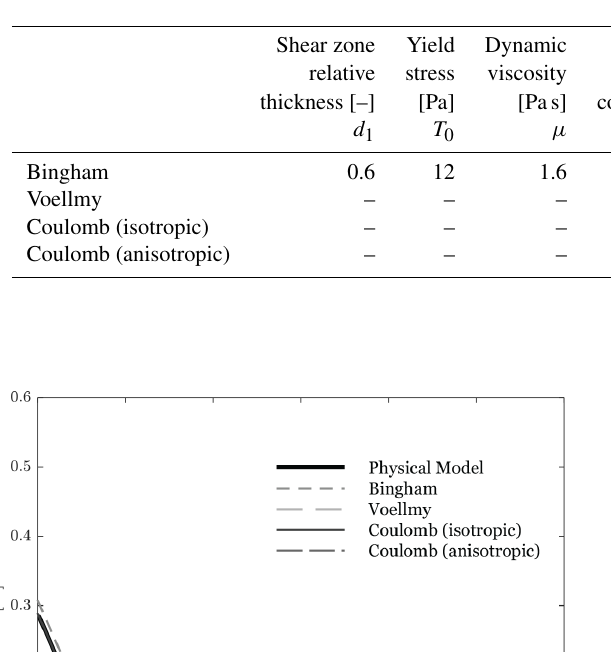
Figure 5. Landslide properties at impact (numerical equivalent location of Cam 1) with a still-water depth h of 0.25m. (a) Time series of slide thickness for different rheological laws (numerical model) compared with the mean thickness in the physical model. (b) Time series of depth-averaged slide velocity for different rheological laws (numerical model) versus the mean velocities in the physical model (modified from Miller et al., 2017). Table 1. Rheological parameters used for the different rheological laws.